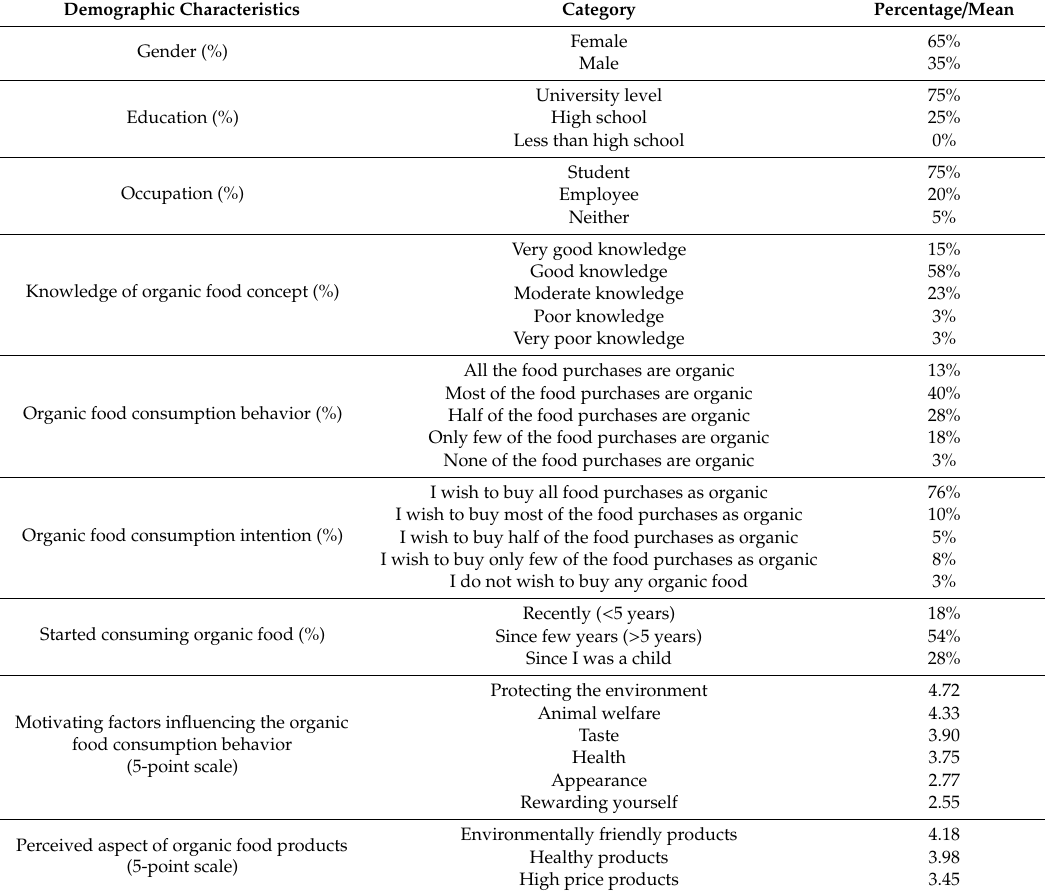
Table 2. Consumers’ demographic characteristics, organic purchase intention and behavior, in addition to the motivating factors behind the organic food purchasing. The data was collected from the cognitive